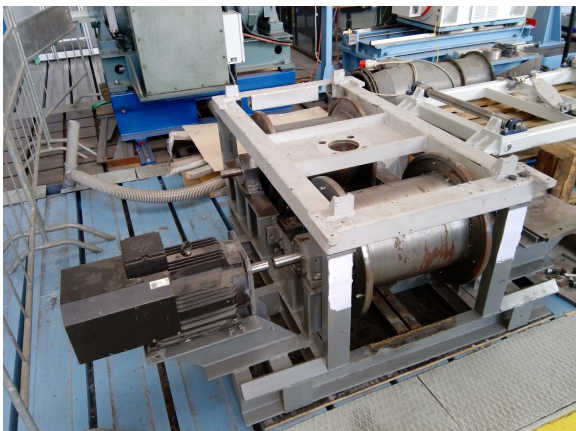
Figure 5. The roller rig – Faculty of Mechanical Engineering at CTU in Prague.